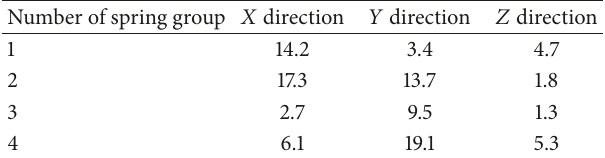
Figure 8: The optimized output and experimental output of the finite element software. Table 5: Results of damping optimization (Ns/m).